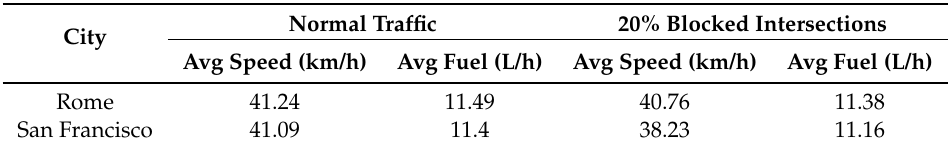
Table 2. Impact of malicious data on average speed and fuel